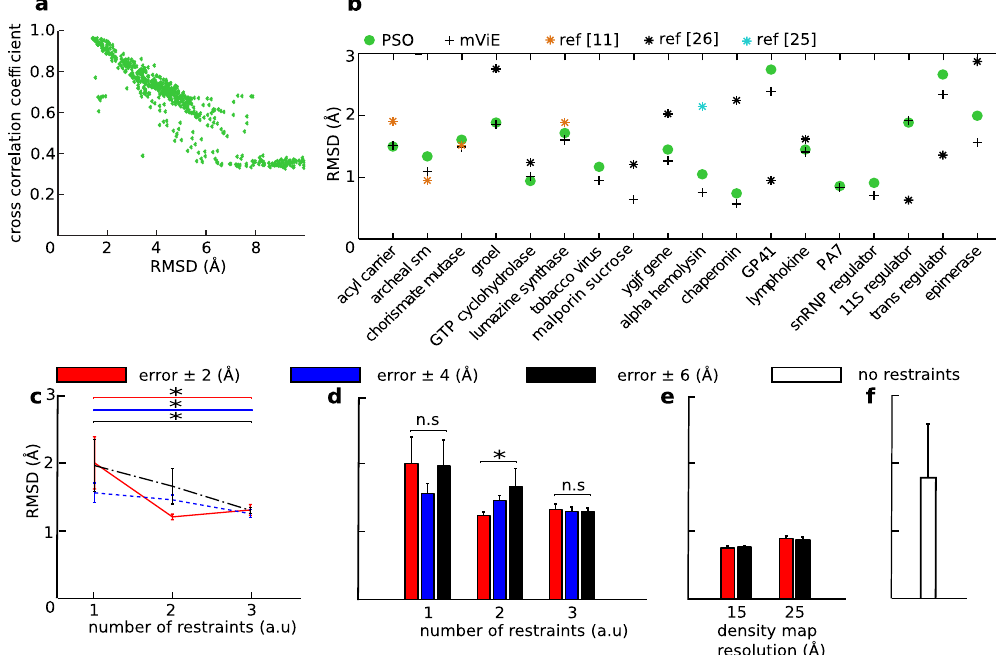
Figure 2. Performance assessment of mViE. ( a ) Cross-correlation-coefficient ( ccc ) and backbone RMSD landscape of the lymphokine assembly models is shown as representative result. ( b ) Performance comparison between mViE, PSO, and the best candidate assemblies of related protein predictions as reported in the literature 11, 25, 26 on 18 symmetrical protein assembly predictions. ( c ) Effect of number of geometric spatial constraints on the quality of candidate assemblies returned by mViE on the GTP-cyclohydrolase homo 5-mer assembly problem (used as representative case, see Supplementary Fig. S2 for extended data). Here the spatial constraints and potential energy were used as constraints on the search space, population diversity as objective and density map ranking as a post-processing step. ( d ) Effect of the quality of spatial constraints (measured as error ± Å) on the quality of candidate assemblies returned by mViE on the GTP-cyclohydrolase homo 5-mer assembly problem. The assembly conditions were the same as in panel (c). ( e ) Results of mViE protocol using density map fitting during assembly of GTP-cyclohydrolase.